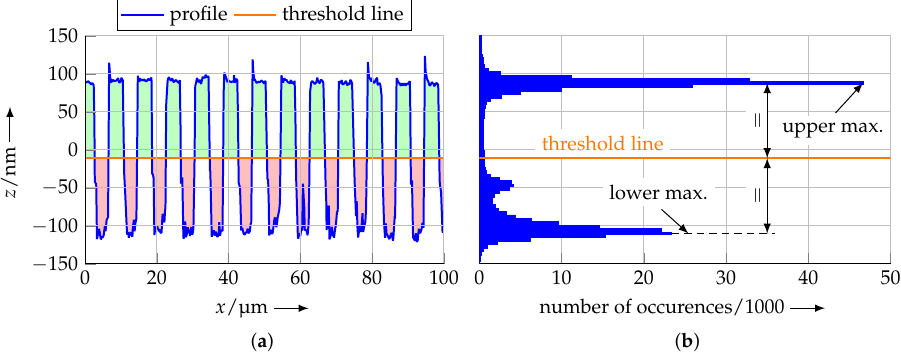
Figure 6. Calculatingthe threshold line from the profile data. A histogram ( b ) is calculated for the measuring points of the profile ( a , detail) over the complete scan length. In the histogram, the peaks above and below the x axis are determined. The threshold line is placed symmetrically between these peaks by calculating their unweighted mean. With the threshold line, the profile can be divided into an upper (green) and a lower (red) part.